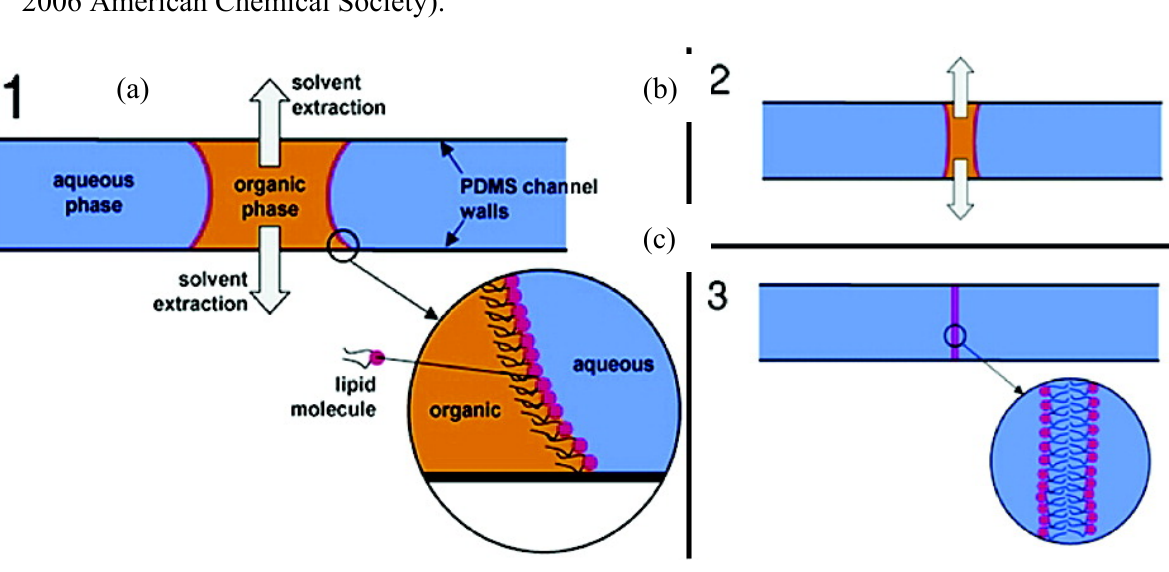
Figure 10. Mechanism for lipid bilayer formation by microfluidic solvent extraction. ( a ) A droplet of organic solvent with dissolved lipid is formed in an aqueous stream of fluid. Lipids are organized on the hydrophobic-hydrophilic interface (inset). ( b ) As solvent enters the PDMS, the two interfaces approach one another. ( c ) Finally, only the lipid layers are left behind, forming a bilayer membrane. (Reprinted with permission from [84].